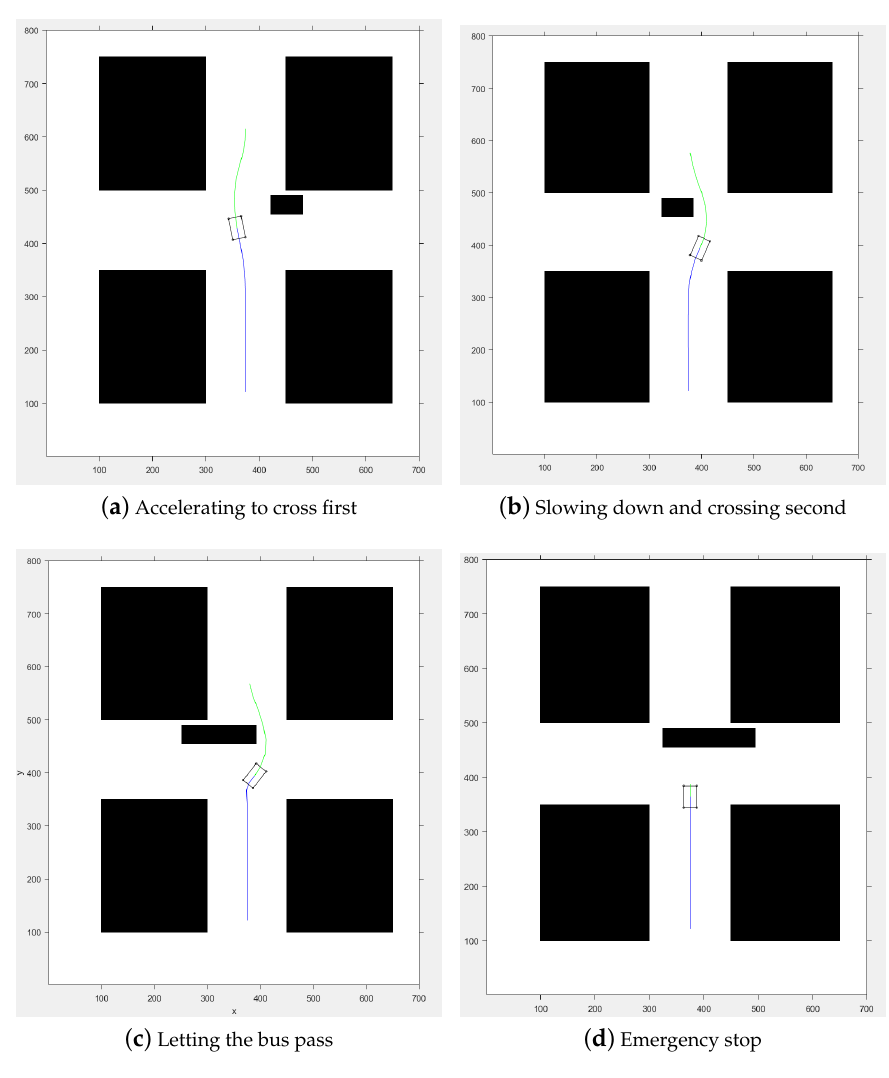
Figure 18. Different scenarios of the ego-vehicle passing an intersection with a moving